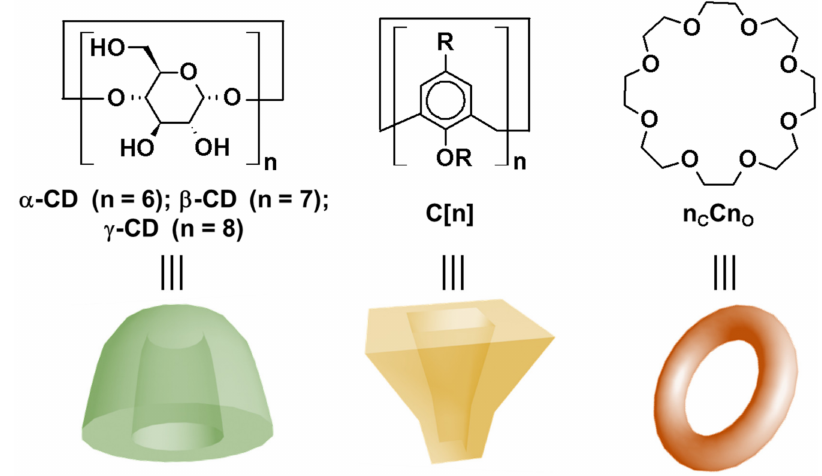
Figure 2. The structure and a schematic representation of different macrocycles (n C = carbon number and n o = oxygen number). CD, cyclodextrin; C, calixarene; nCn, crown ether. CDs are water-soluble hosts able to accommodate a large variety of hydrophobic molecules [40].